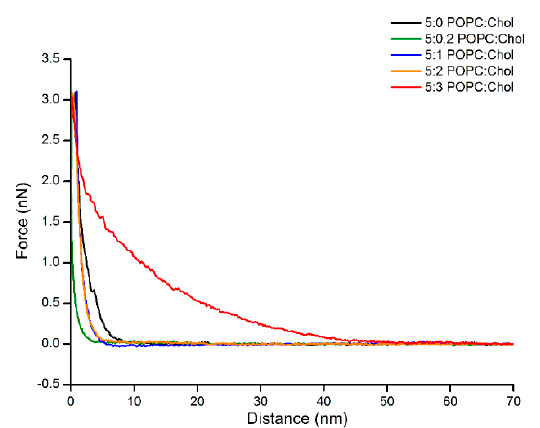
Figure 8. Approaching force–distance curves of Cyt2Aa2/lipid layers with different levels of cholesterol content. The AFM tip was moved close to the surface until reaching the contact point (close to zero point), then force was increased to the set point (3 nN). The force–distance curve was carried out at 1 Hz. Long-range repulsion is observed in the case of protein adsorption on 5:3 (POPC:Chol) ratio.